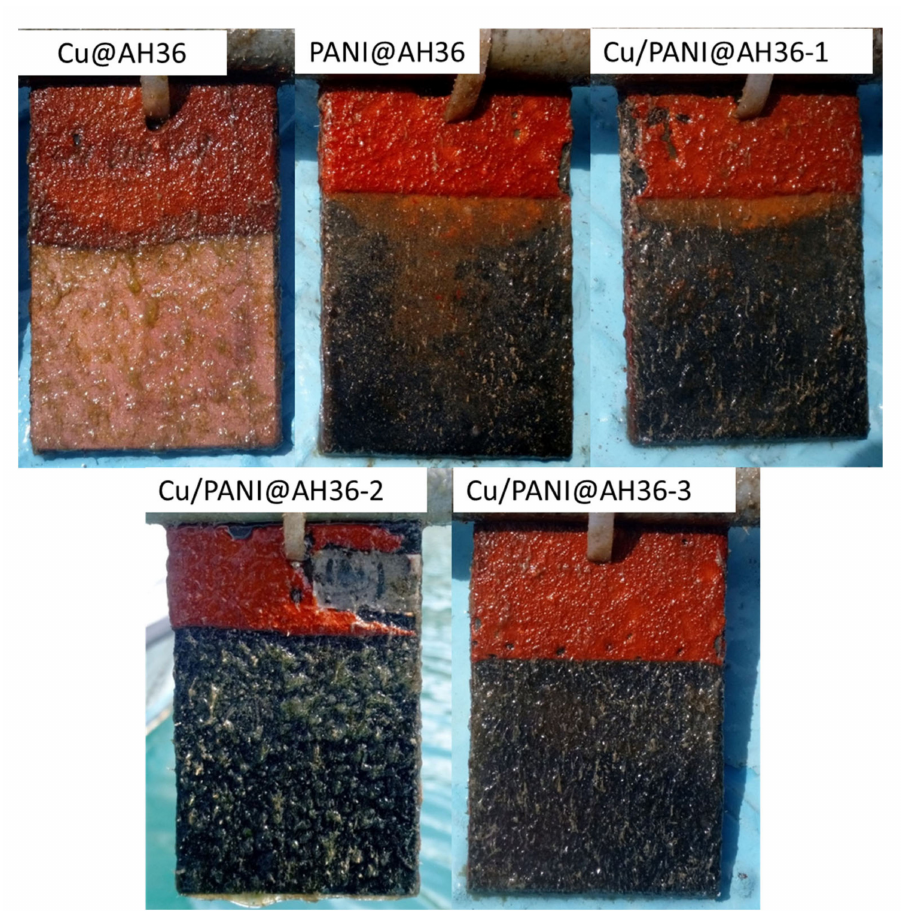
Figure 8. The visual appearance of the different coated samples after exposure to seawater for 60